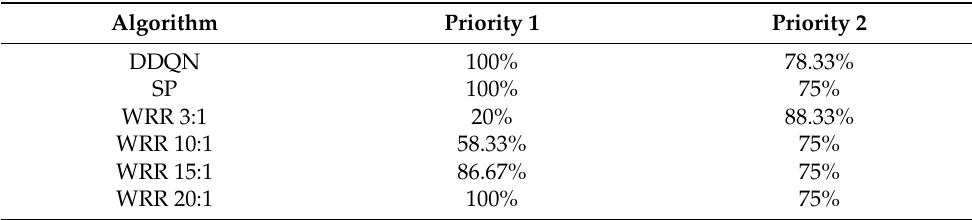
Table 10. WRR result at S5 according to different weights in topology.